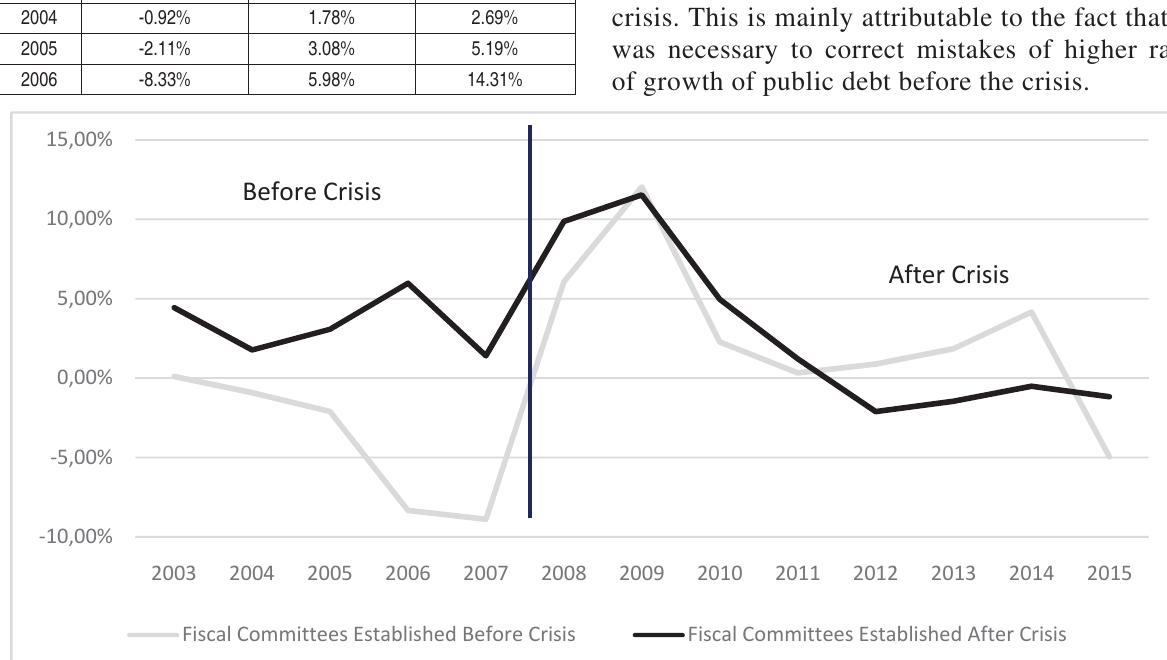
Fig. 2. Average change of public debt – GDP